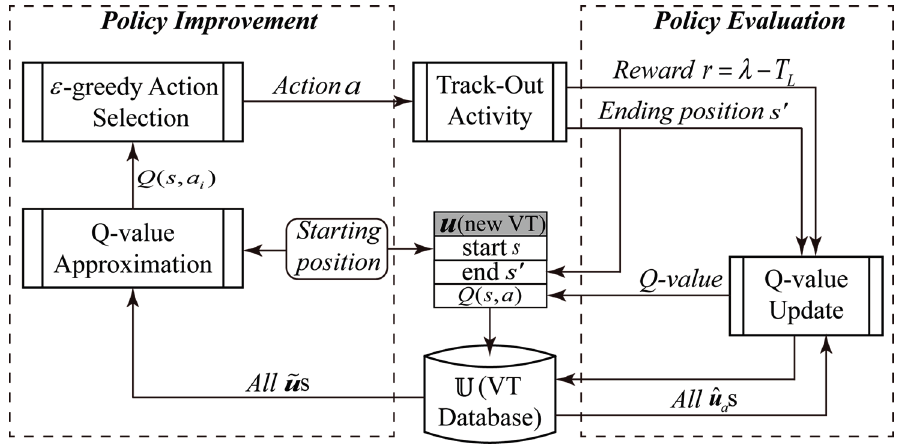
u s denote the nearby VTs of u and the a